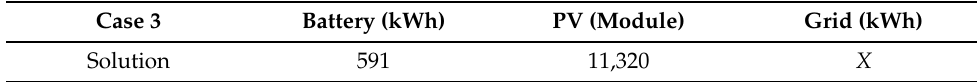
Table 4. Solution of Case 3.